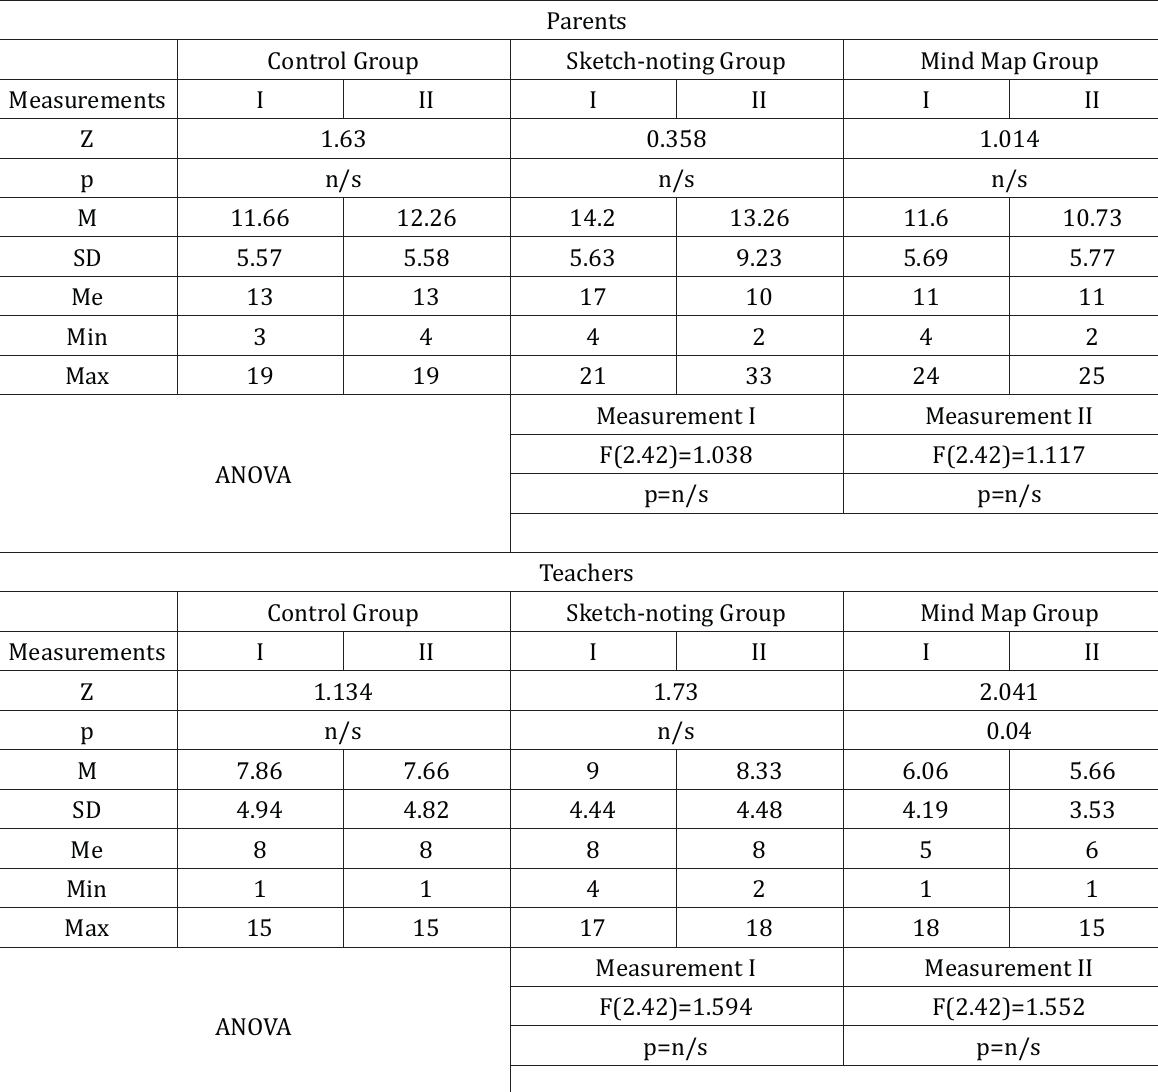
Table 3. Comparison of the results of the means of the learning problems variable in the first and second measurement assessed by parents and